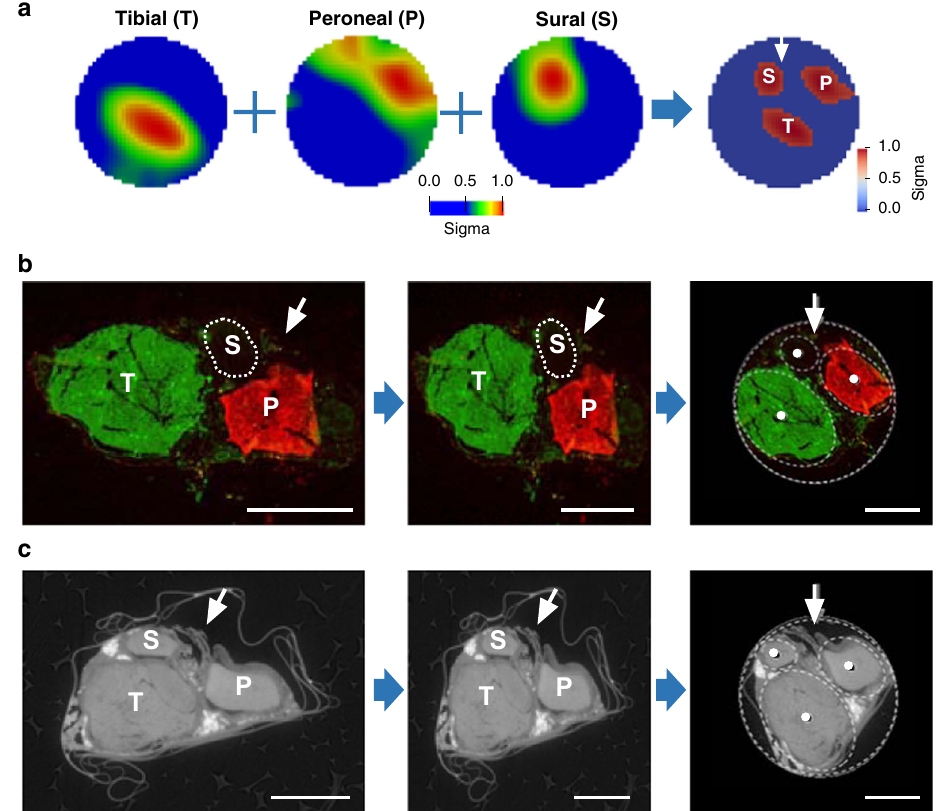
Fig. 4 Examples of co-registration of fascicle angular location with three techniques. a Individual images of evoked fascicular activity reconstructed from EIT recordings and the merged image of reconstructed top 10% activations for all three fascicles. All EIT recordings are taken in two repeats for each fascicle to ensure the reproducibility, but just one recording was used for reconstruction. b Left: fl uorescent image of the cross-section of the common sciatic nerve at the area corresponding to EIT recordings with tibial fascicle labeled with fl uorescent Dextran-Alexa 488 (green) and peroneal fascicle with Dextran-Alexa 555 (red). The margins of the sural fascicle that did not receive tracer injection are demarcated with a dashed line. Middle: single-axis rescaling. Right: rotation of histology image for purposes of cross-validation of centers of mass (CoMs) of fascicles between three techniques. The external boundaries of the nerve were fi tted to a circular pro fi le after rigid deformation. Each fascicle was fi tted into an ellipsoid pro fi le (dashed white line) with a CoM (white dot in the middle), which was further used as a ground truth coordinate in the cross-validation study. Scale bar is 500 μ m. c Left: representative X Y plane slice of the microCT scan of the nerve in the area corresponding to EIT recordings with fascicles clearly visible and snippets of the silk thread marking the EIT cuff opening area (pointed at with white arrow). Middle and right: rigid deformation and rotation of microCT image for co- registration. Scale bar is 500 μ